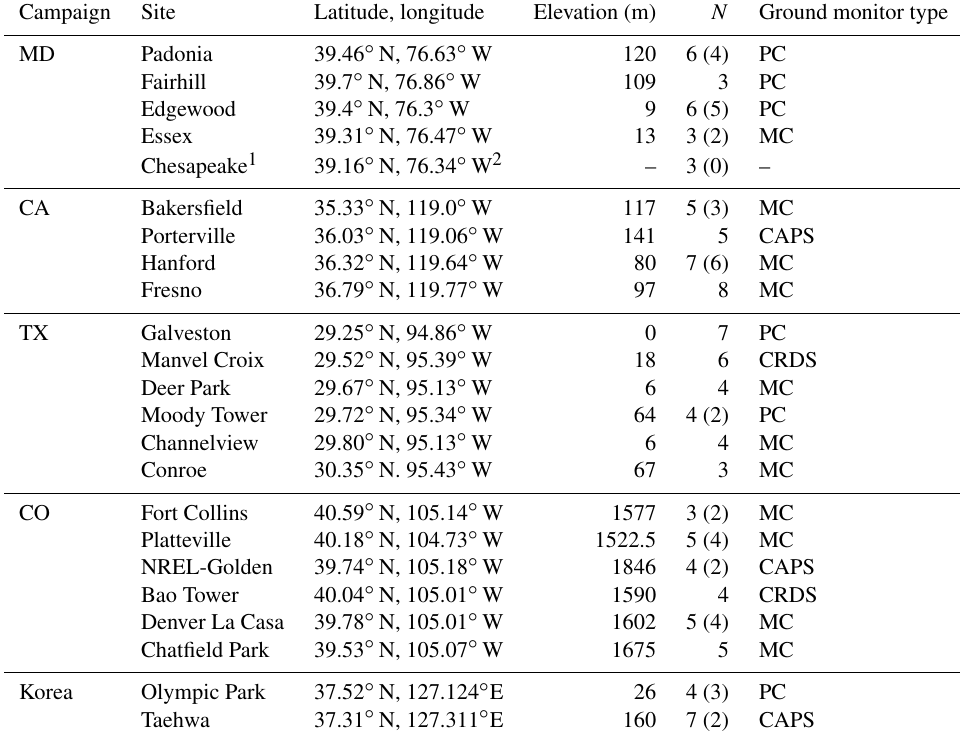
Table 2. Summary of ground supersites during DISCOVER-AQ and KORUS-AQ campaigns with ground-based NO 2 measurements. The symbol N represents the sample size for aircraft and Pandora (in parentheses if different from that of aircraft profiles) measurements that are collocated with OMI observations. Surface NO 2 monitors include NO x analyzers with molybdenum converters (MCs), NO x analyzers with photolytic converters (PCs), cavity-attenuated phase shift (CAPS) spectrometers, and cavity ring-down spectrometers